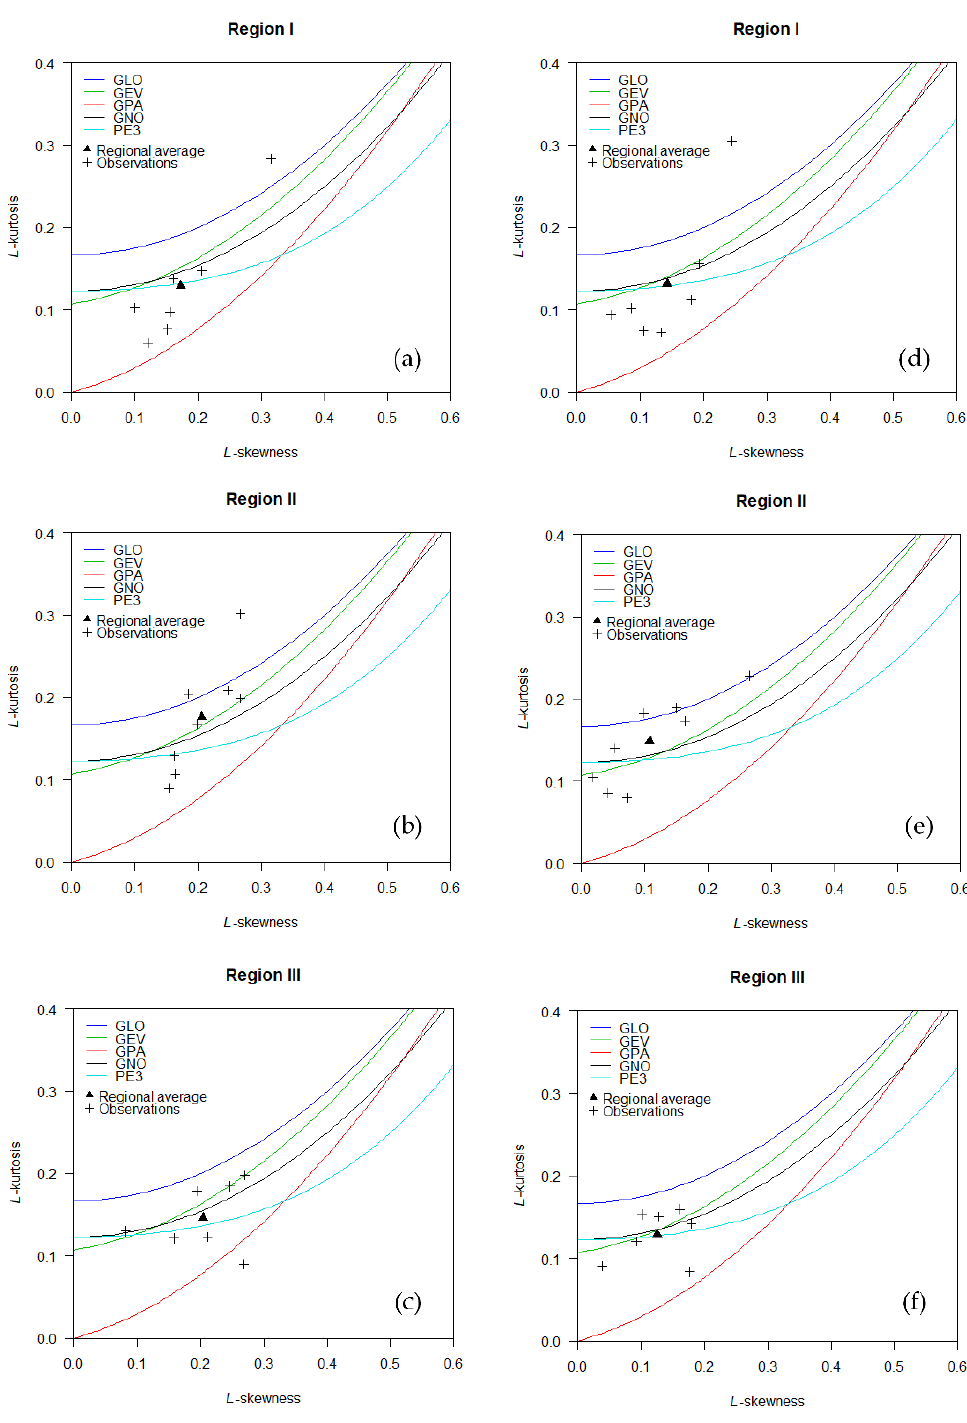
Figure 4. L-moment ratio plot for RX7day ( a , b , c ) and R95P ( d , e , f ) series at three HOM regions. Figures 5 and 6 plot the observed and simulated values for each region of RX1day, RX5day, RX7day, R95P series, respectively. They show that the points fall on the line closely enough for the optimal distributions for each HOM region. The MARE results for each HOM region of RX1day, RX5day, RX7day, R95P series summarized in the last column of Table 3 demonstrate that the MARE values range from 3.19% to 6.41% and the best-fit distribution for each HOM region can describe